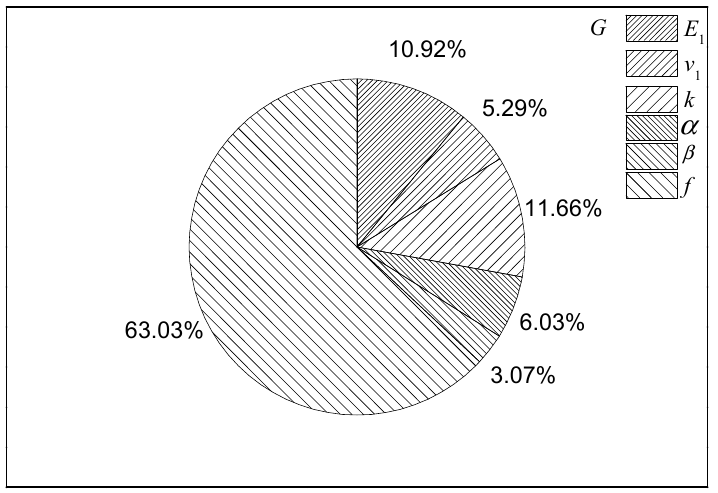
Figure 6. FSIs computed by the EFAST sensitivity analysis for the shear modulus in the C30 concrete.